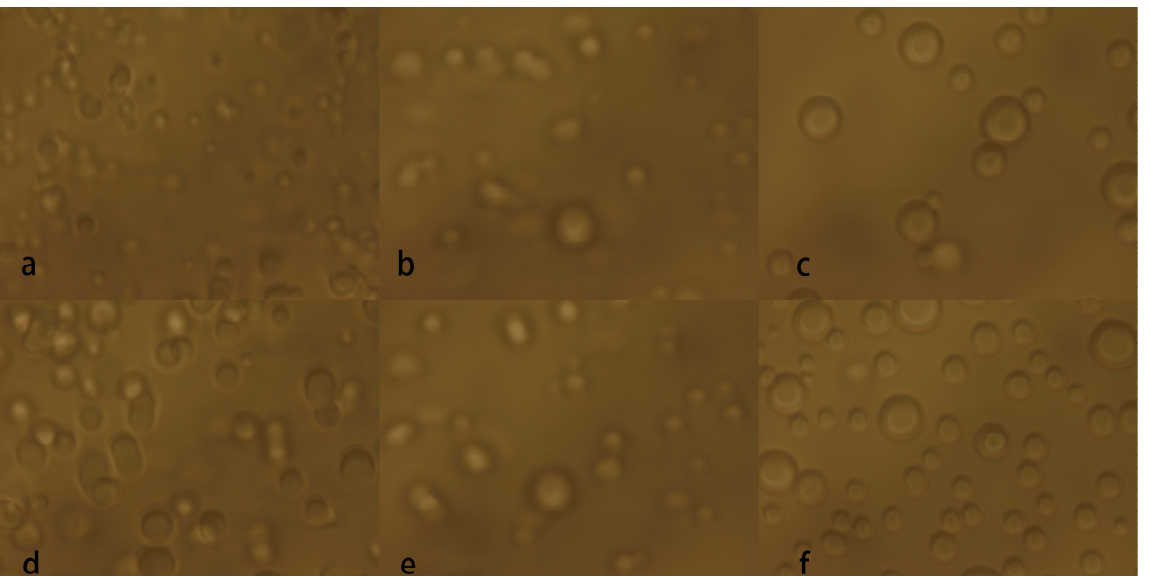
Figure 10. The LLPS comparison diagram of BSA under the condition of a fixed BSA concentration 50 mg/mL. ( a ) YCl 3 3mM, DDAO 3mM; ( b ) YCl 3 3mM, DDAO 30mM; ( c ) YCl 3 3mM, DDAO 50mM; ( d ) YCl 3 7mM, DDAO 3mM; ( e ) YCl 3 7mM, DDAO 30mM; ( f ) YCl 3 7mM, DDAO 50mM .